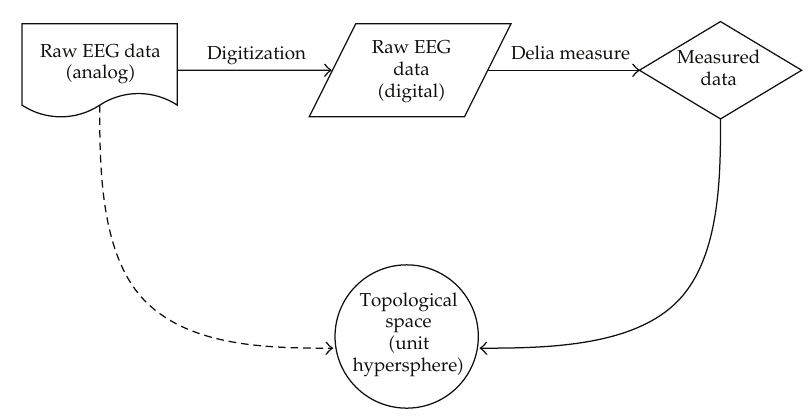
Figure 4: Pathway to mapping EEG signals to a